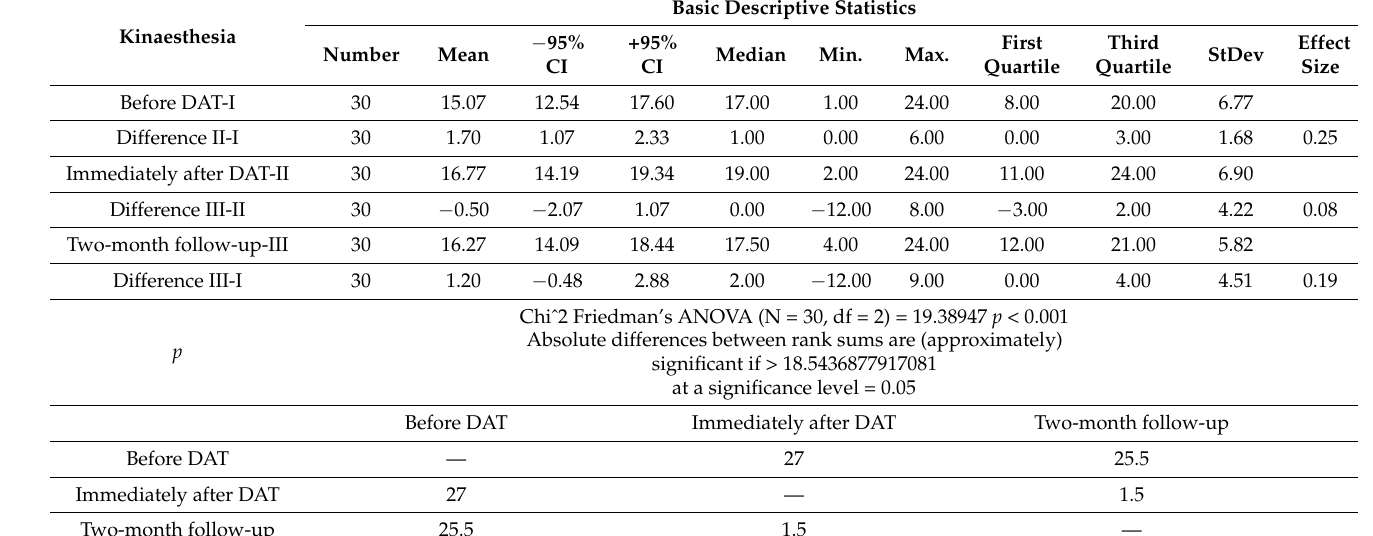
Table 4. Kinaesthesia—analyses of the measurements performed over